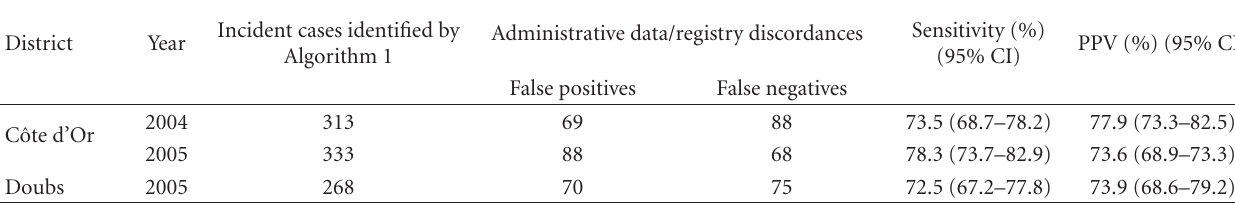
Table 2: Algorithm 1 results by district and diagnostic year: sensitivity and positive predictive value of administrative data for identifying incident colorectal-cancer cases versus cancer registries used as the gold standard.